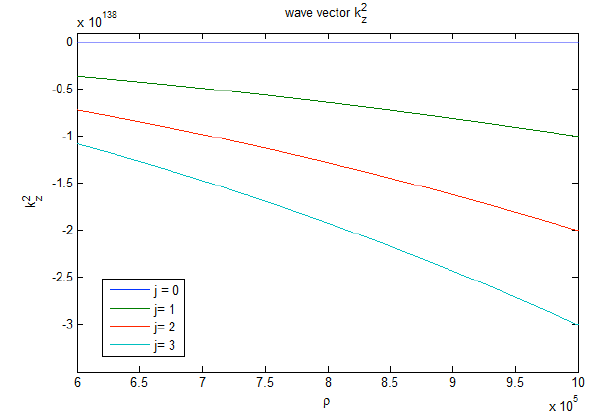
Figure 2: The graph of wave vector 2 k with variation j and p j z Then for the fields distribution, we investigated from the total eigenfunctions using equations (6,12,30-31) for j=1,2,3 and j=4 , and we take the positive sign for E(z) , we